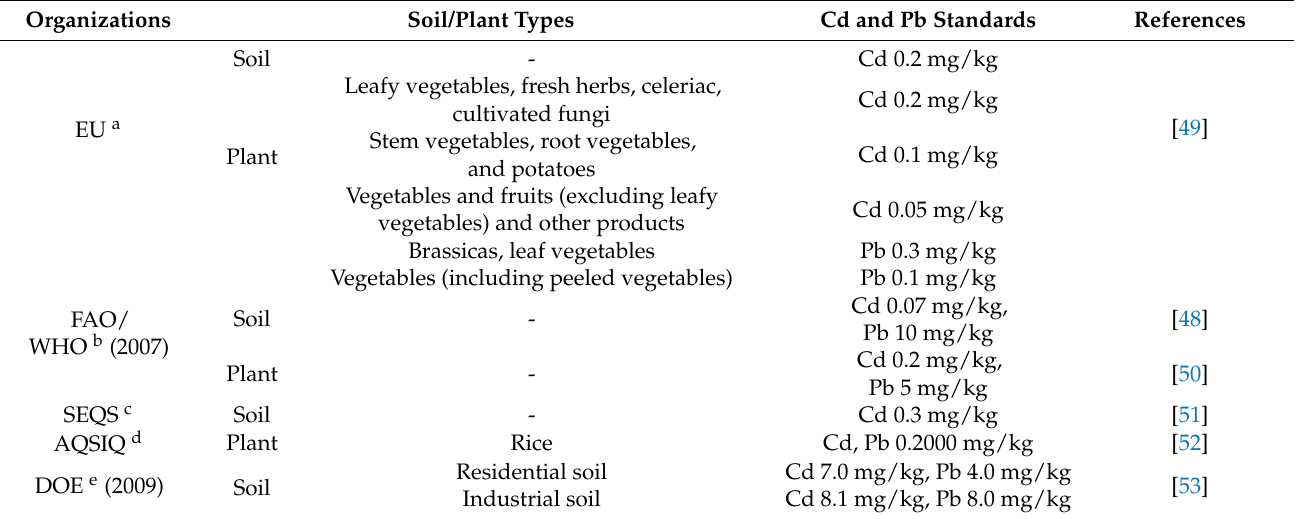
Table 2. Maximum levels for cadmium and lead in both food and soil from different